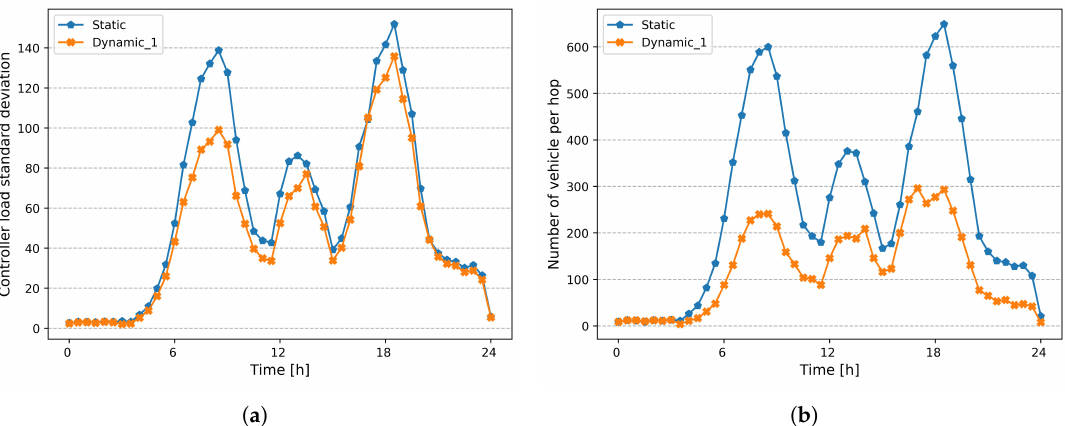
Figure 10. Comparison of Static and dynamic Placement strategies. ( a ) Standard deviation of Controller Load; ( b ) Number of vehicle per 3